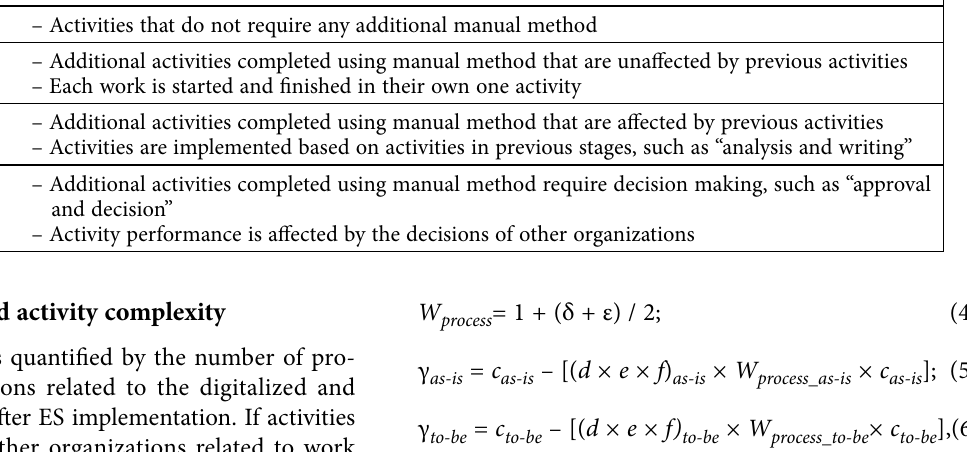
Table 6. Classification criteria of the effects of automated and digitalized activities